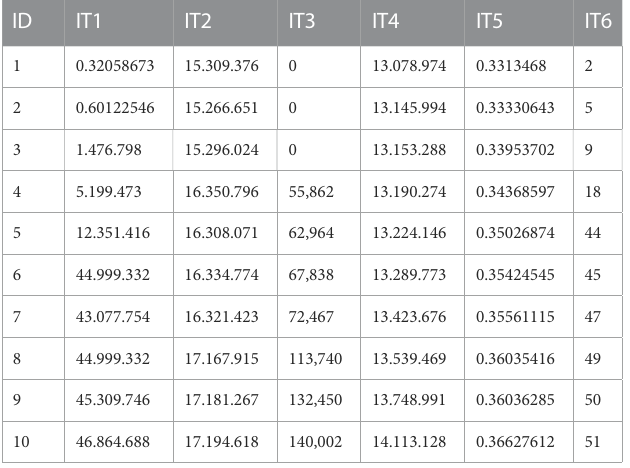
TABLE 4 Example of the data items.